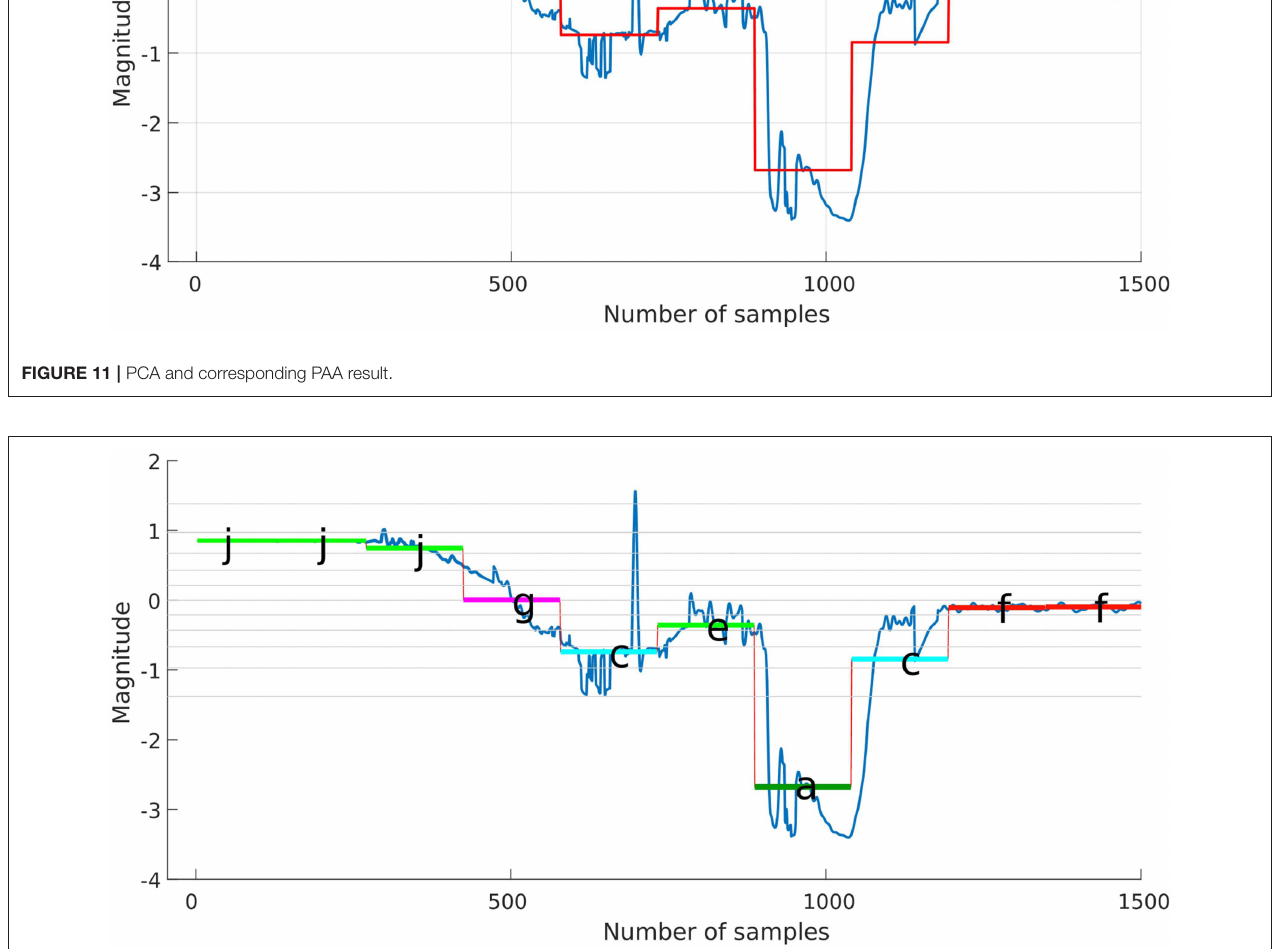
FIGURE 12 | Symbolic representation with five segments using